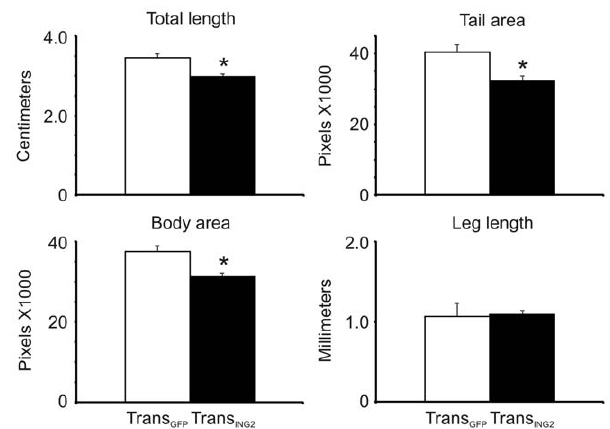
Figure 1. Comparison of morphological characteristics of ING2 - overexpressing tadpoles (Trans ING2 , filled bars; n=19) and transgenic tadpoles expressing GFP only (Trans GFP , empty bars; n=10). The asterisk denotes a significant difference between the two groups (ANOVA, p , 0.001; body area: Mann Whitney U, p=0.005). The error bars represent the standard error of the mean.